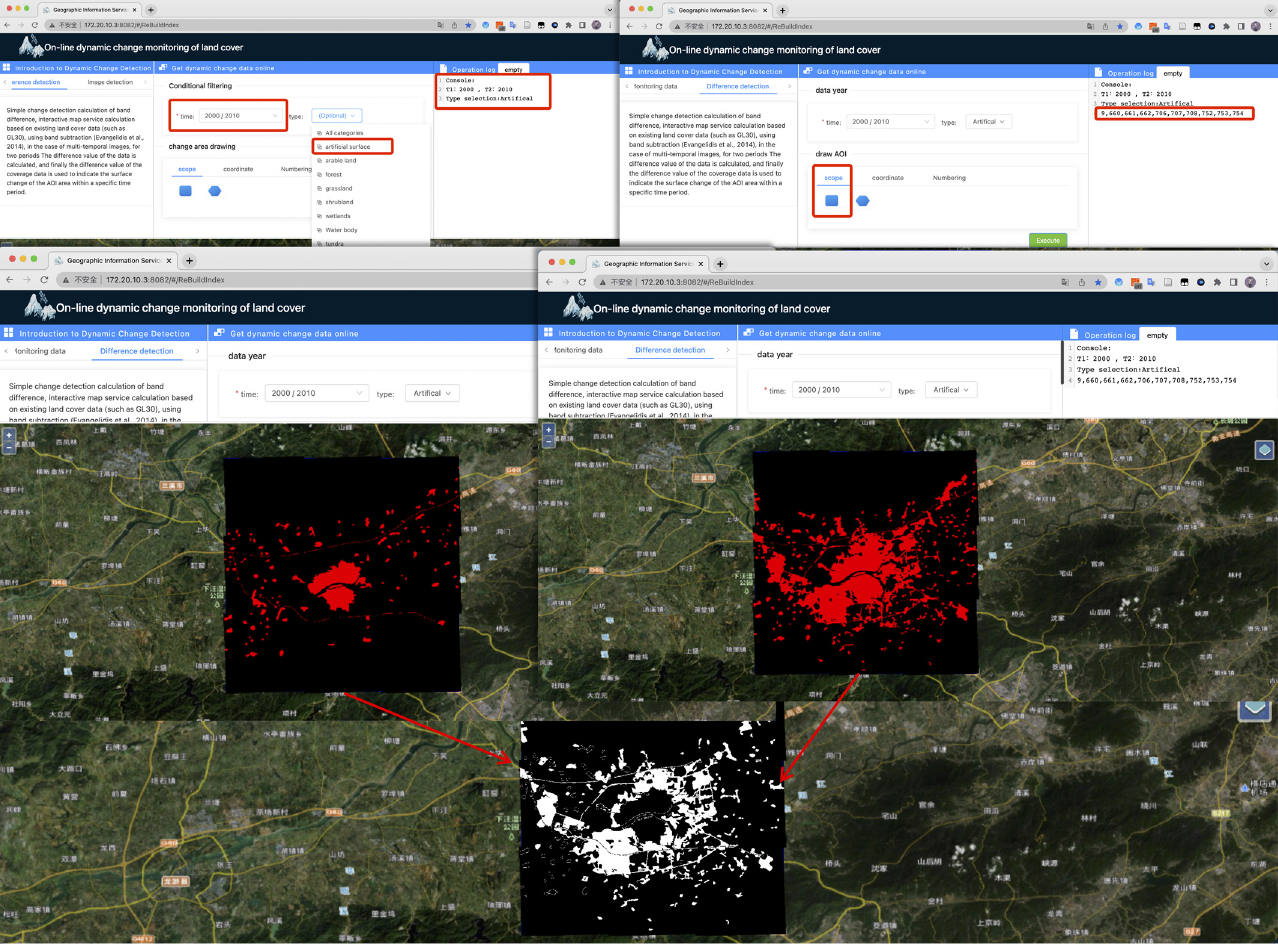
Figure 12. Application of band subtraction change detection.